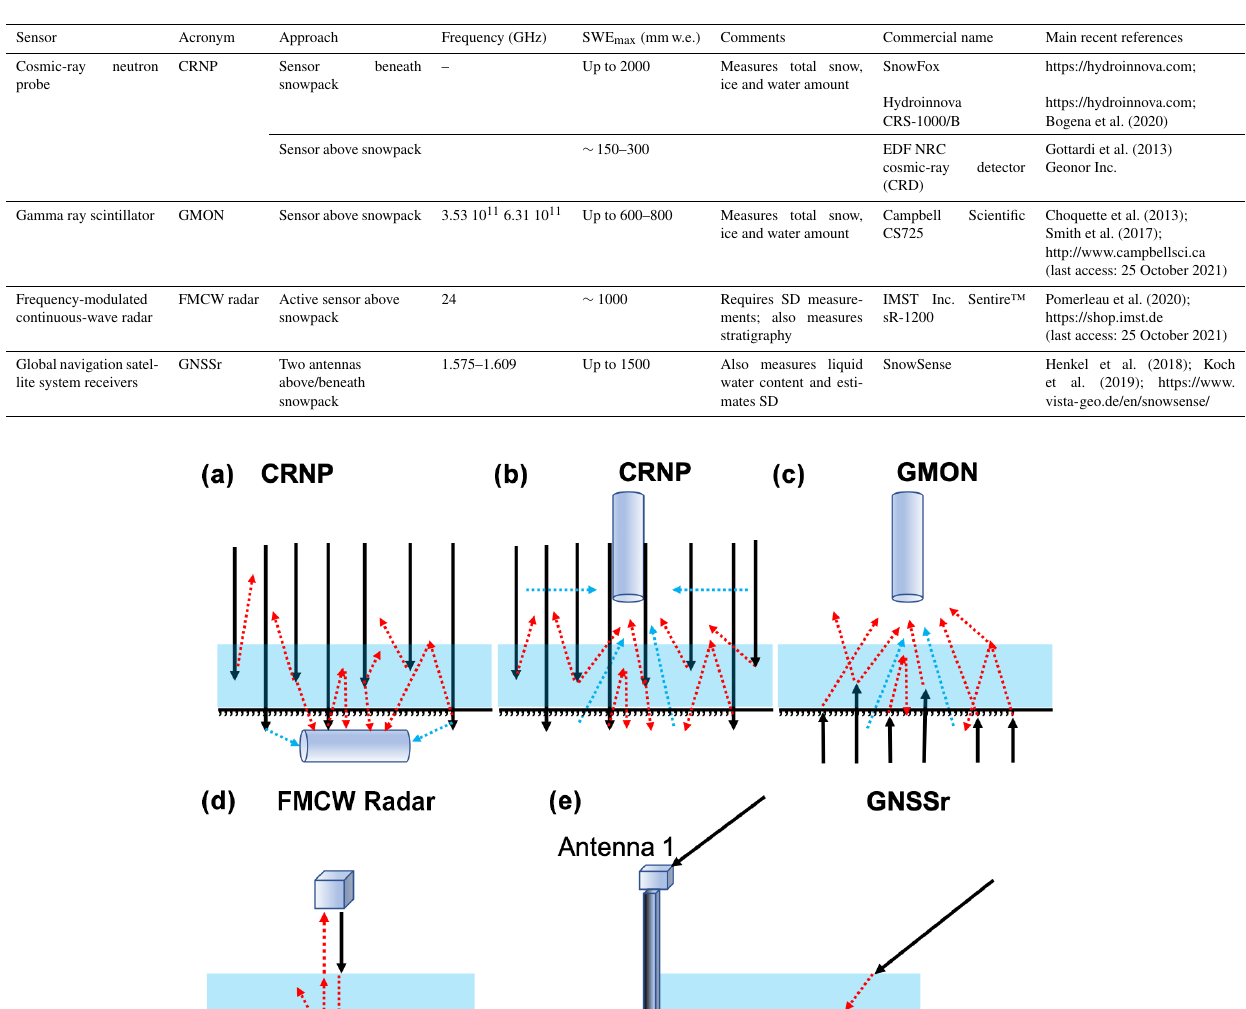
Table 1. SWE sensors that were studied and acronyms that were used. FMCW: frequency-modulated continuous-wave radar. GNSS: global navigation satellite system, including GPS (Global Positioning System, USA), GLONASS (Russia), Galileo (Europe) and BeiDou (China) satellite constellations. The frequency of the electromagnetic (EM) wave that was used and their approximate maximum water equivalent of snow (SWE max ) measurement limit capabilities are given. SD: snow depth. See Fig. 1 for measurement principle conceptualization and Fig. 2 for photos.